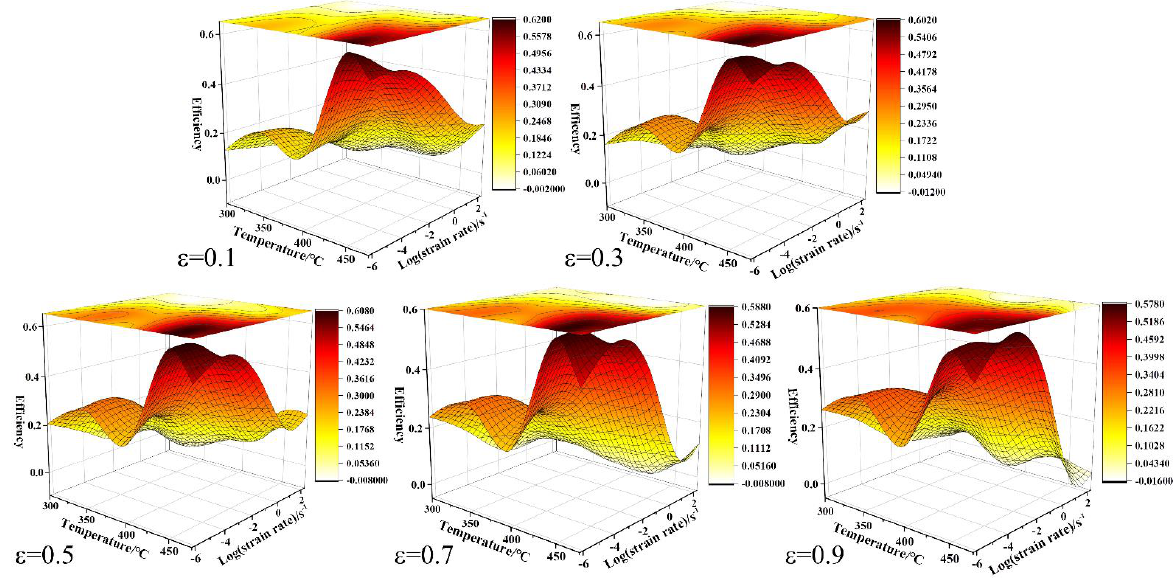
Figure 10. Efficiency maps of power dissipation for the Mg-8.7Gd-4.18Y-0.42Zr alloy at different strains.